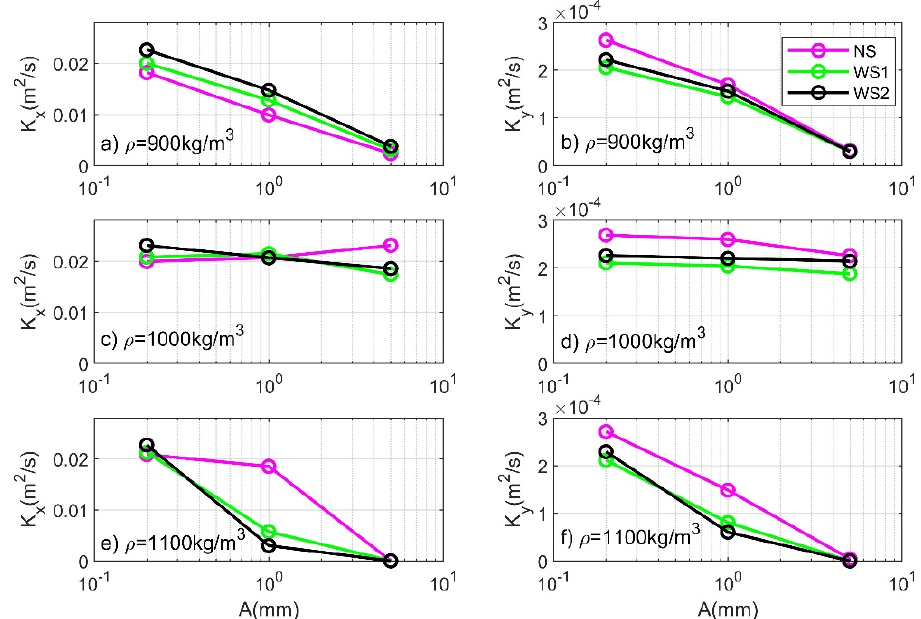
Figure 8. Relative dispersion coefficients K in the horizontal direction ( a , c , e ) and in the vertical direction ( b , d , f ) depending on particle size A in the log scale.